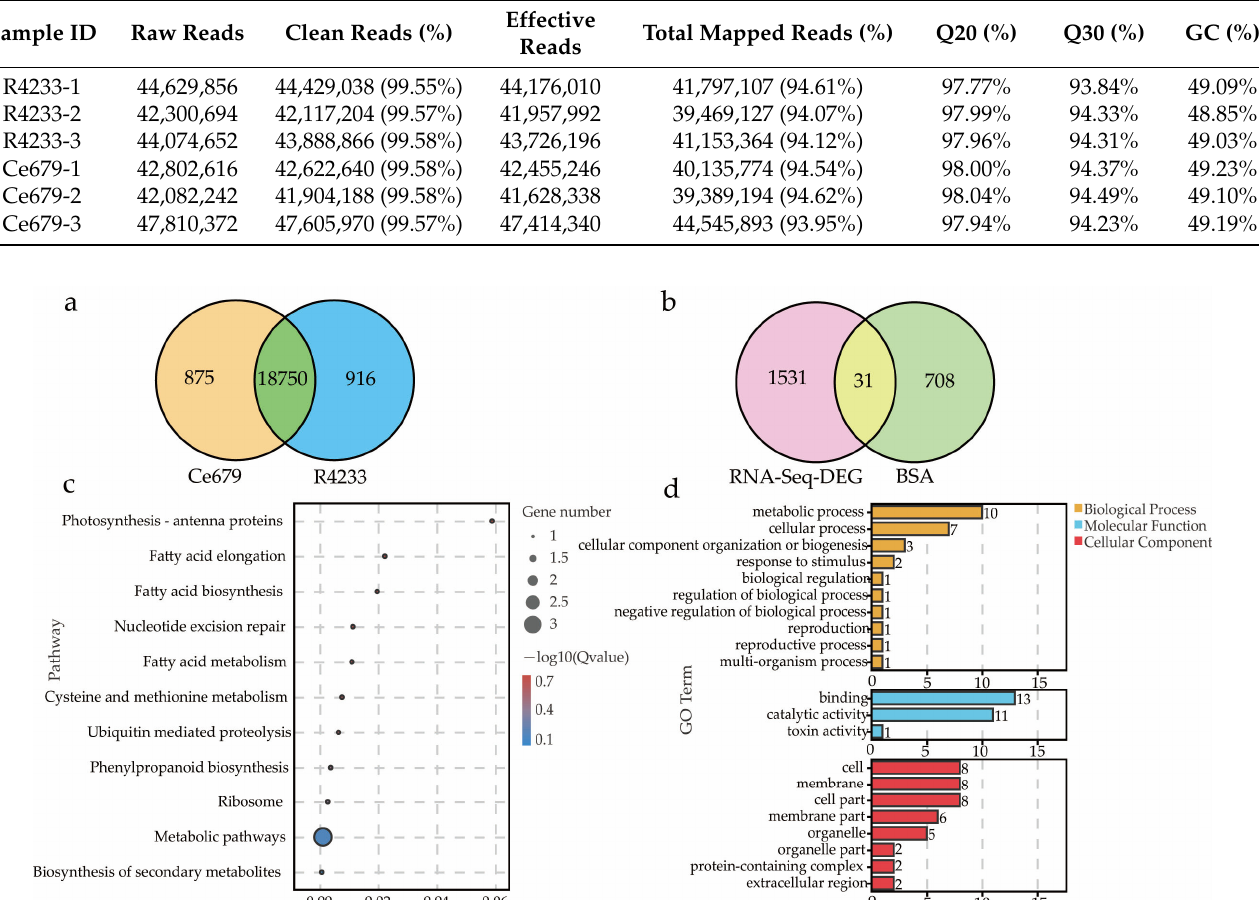
Table 5. Summary of mapping reads and RNA-Seq.